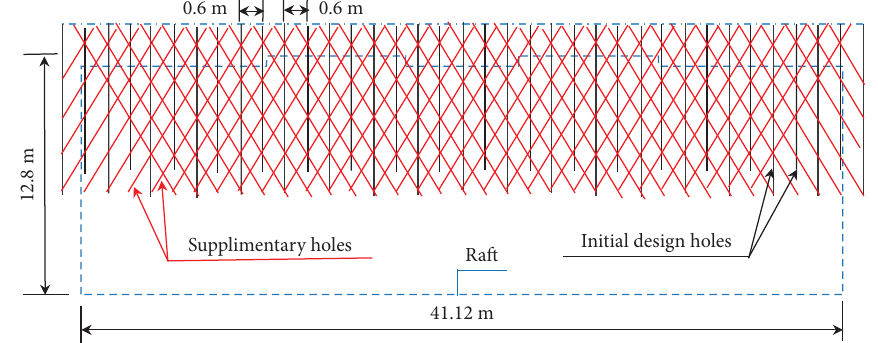
Figure 9: Hole confguration of case 2.